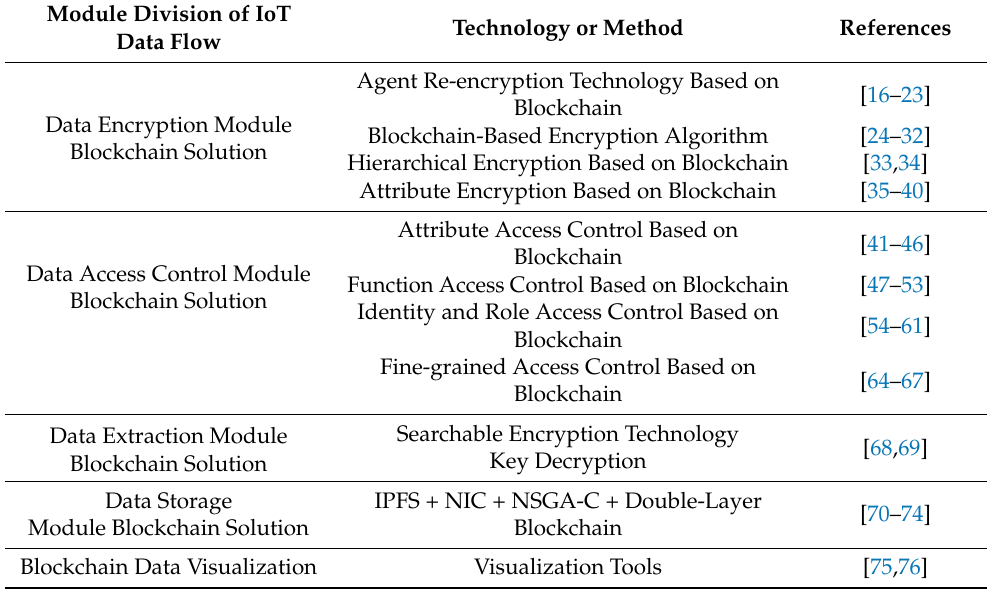
Table 3. Summary of Internet of Things data flow blockchain